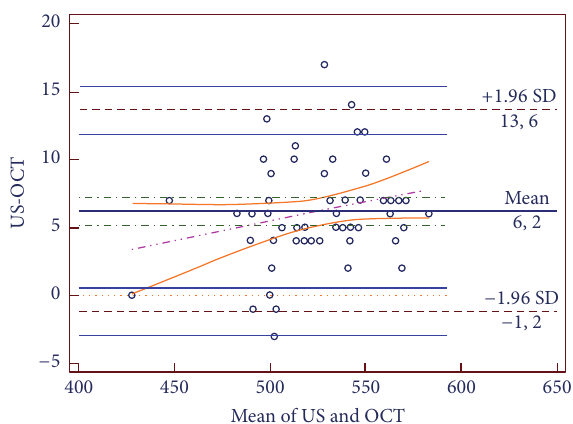
Figure 1: Bland-Altman plot of the difference in mean CCT values based on Cirrus SD-OCT and ultrasonic pachymetry in patients with